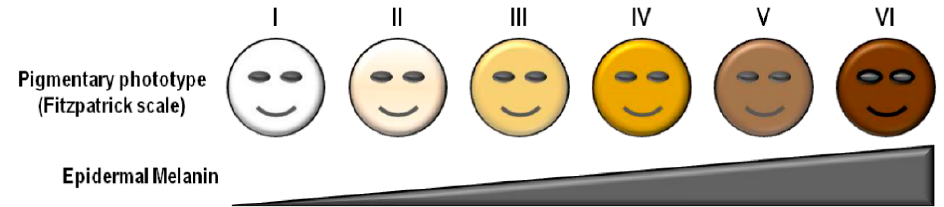
Figure 2. The Fitzpatrick Scale, ranging from I (little epidermal melanin, ~3% volume fraction melanosomes) to VI (significant epidermal melanin, ~43% volume fraction melanosomes) [39].